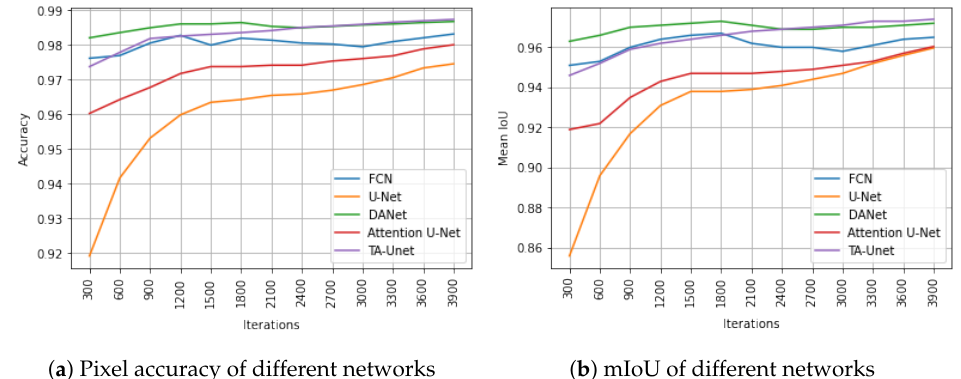
Figure 3. Pixel accuracy and mIoU of different networks on the validation set. The x-axis represents pixel accuracy (PA) and mean IoU in subfigures ( a , b ), respectively, while the y-axis stands for number of iterations in both